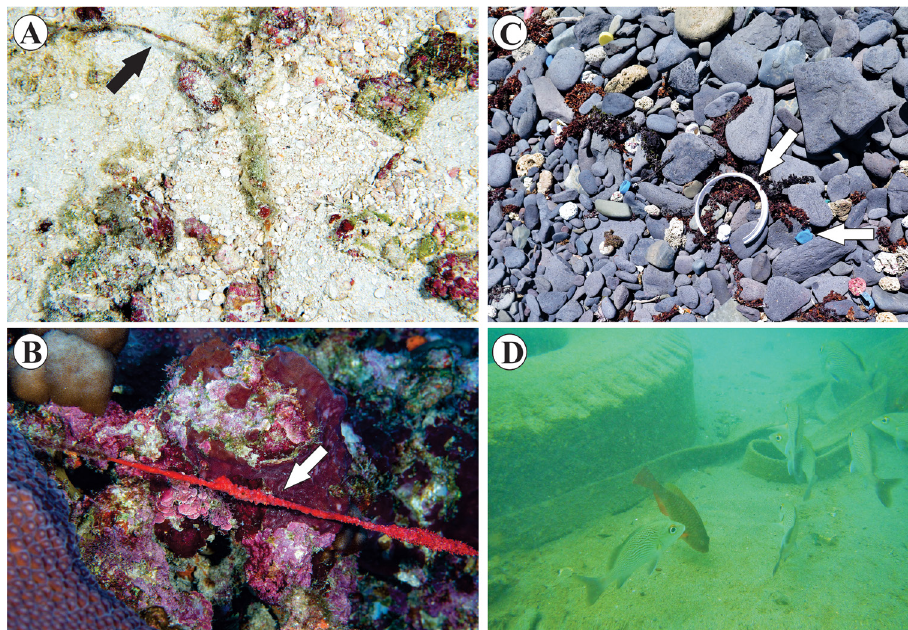
FIGURE 7 | Evidence of human impacts (arrows) by fishing debris, plastics and other trash found in the ecosystems explored around the Fernando de Noronha Archipelago. A. and B. Mesophotic (> 30 m deep); C. Intertidal; and D. Shallow ecosystems (≤ 30 m deep). Photos A and B by L. A. Rocha and photos C and D by J. L.